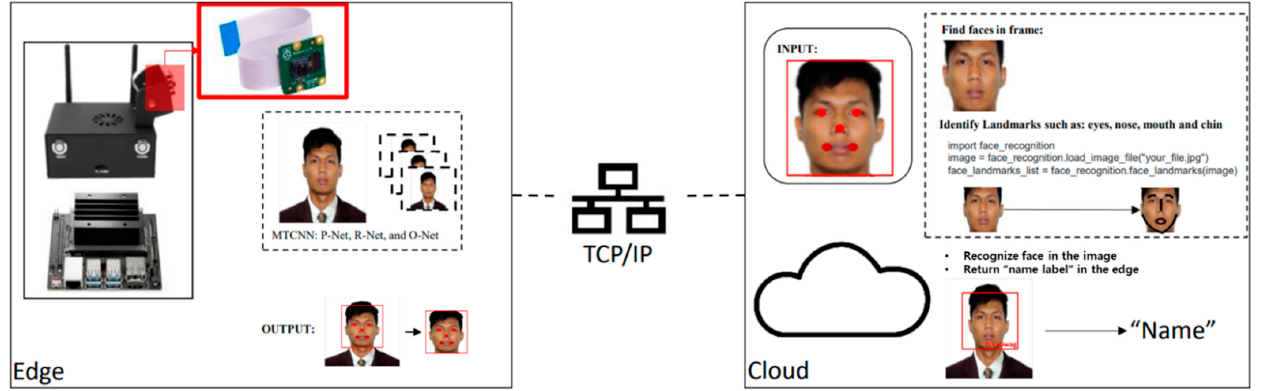
Figure 1. Proposed edge–cloud